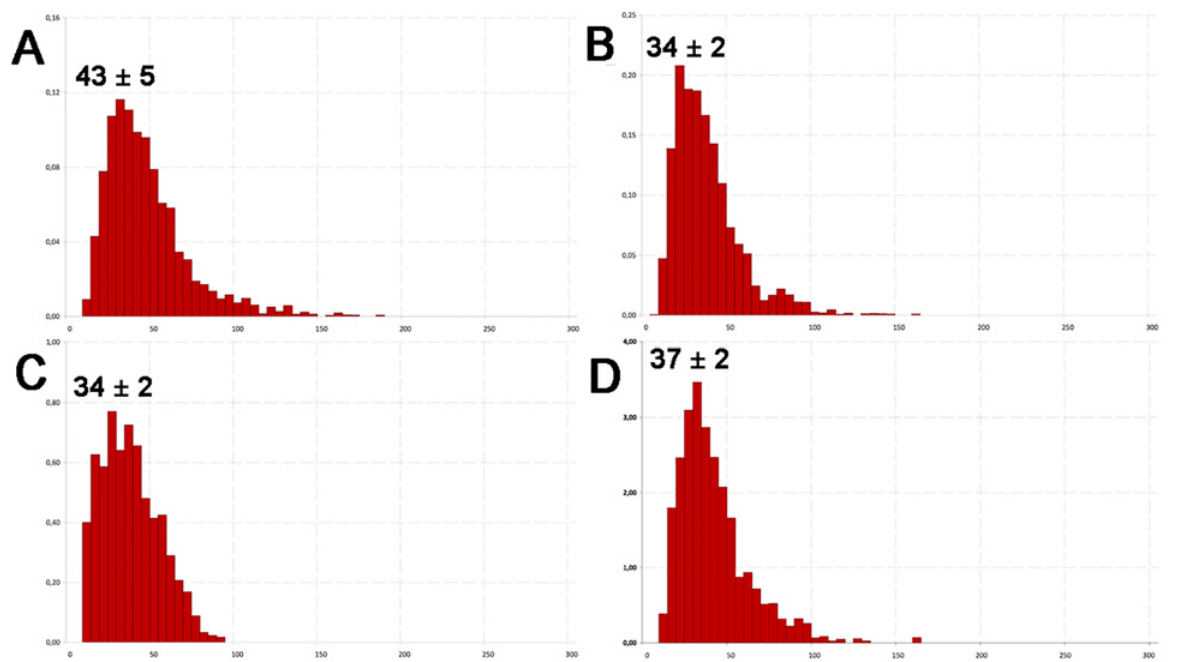
Fig 3. Analysis of virions hydrodynamic size for CaMV (A), EMCV (B), BMV (C) and BMMV (D) using nanoparticle tracking analysis. Concentration ×10 12 particles per ml ( y -axis), diameter in nm ( x